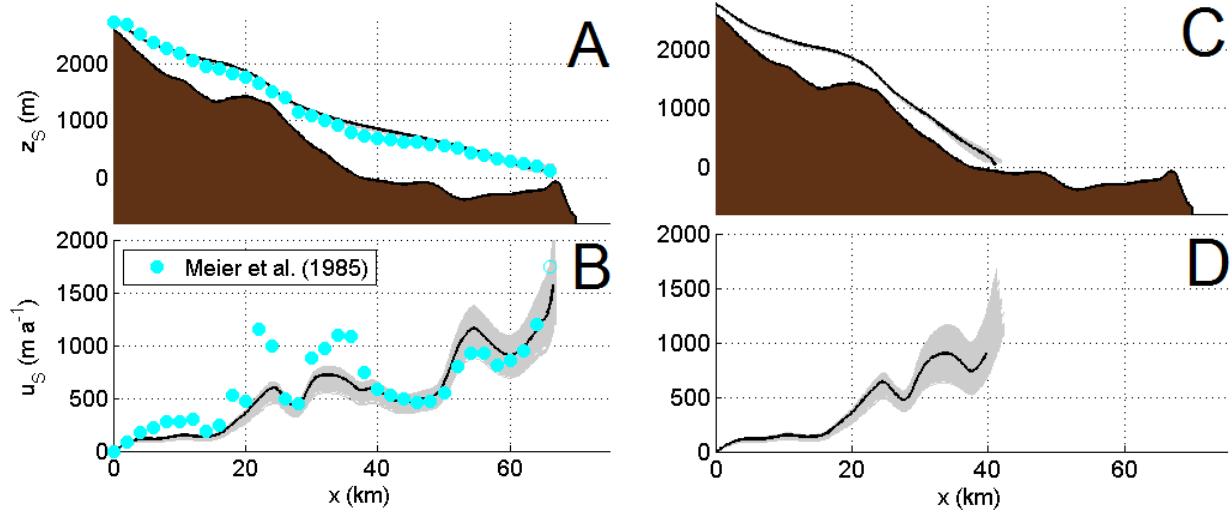
Fig. 11. Modelled (grey lines with ensemble mean in black) and observed (points; Meier et al., 1985) ice surface elevation ( z s ) and ice surface velocity ( u s ) along the Columbia Glacier main flowline ( x) in 1977/78 (pre-retreat; A and B ) and in 2100 (post-retreat; C and D